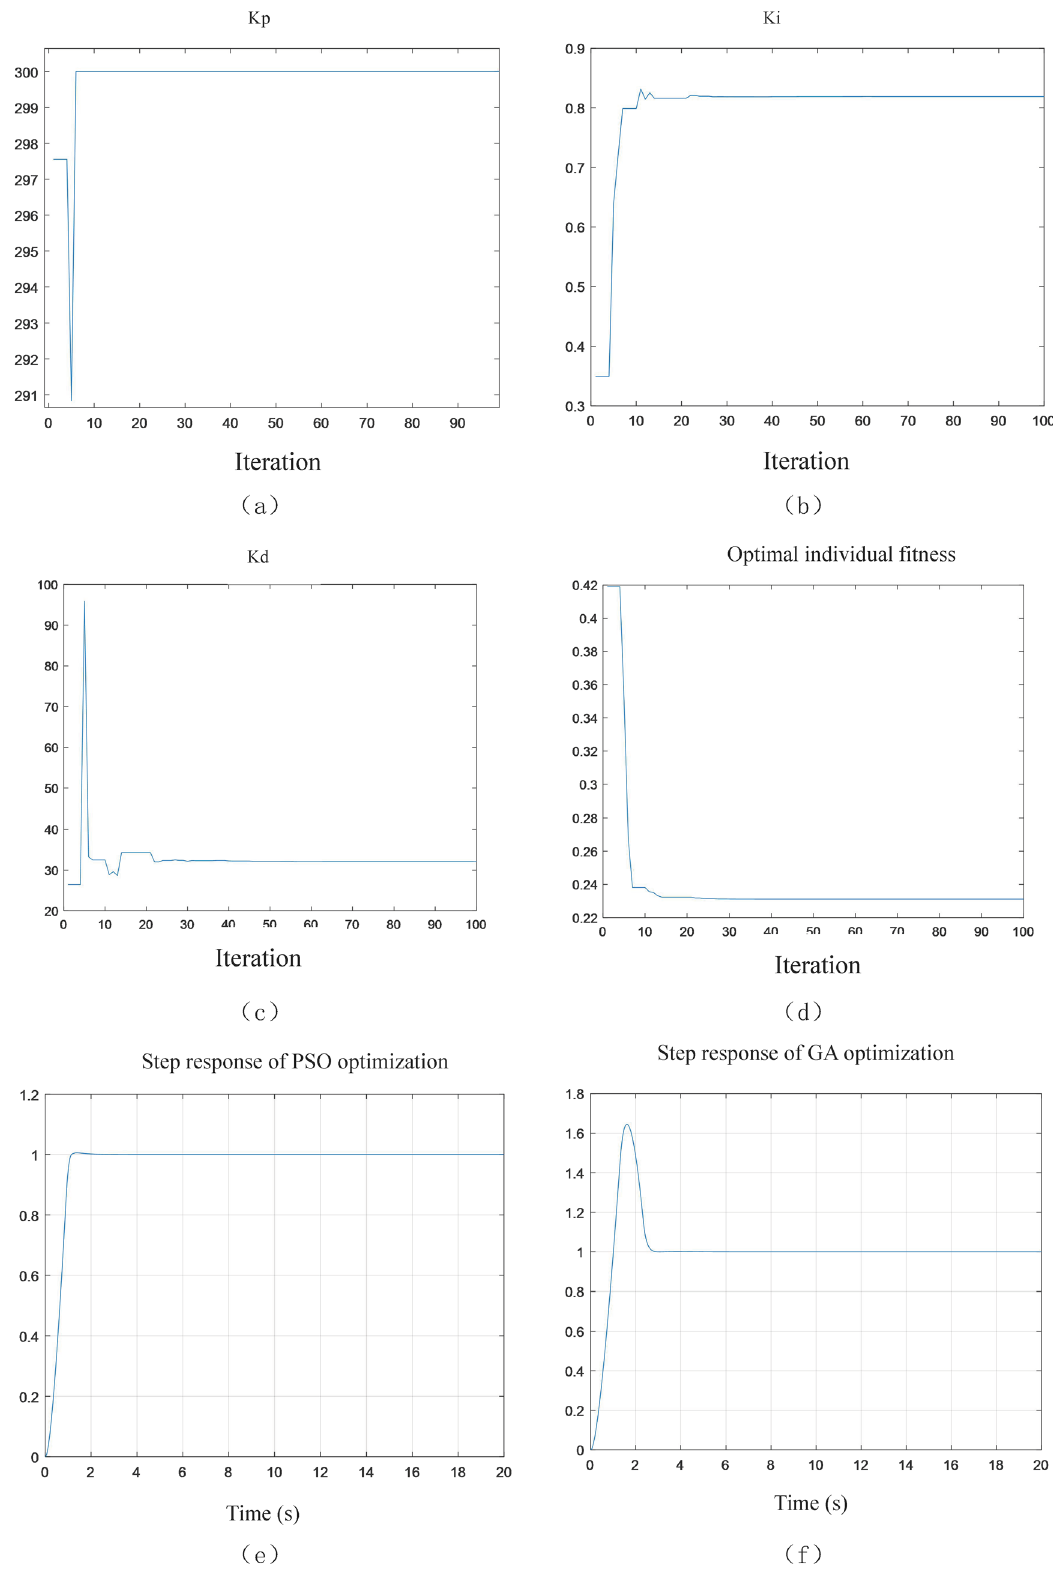
Figure 10. Optimization results of particle swarm